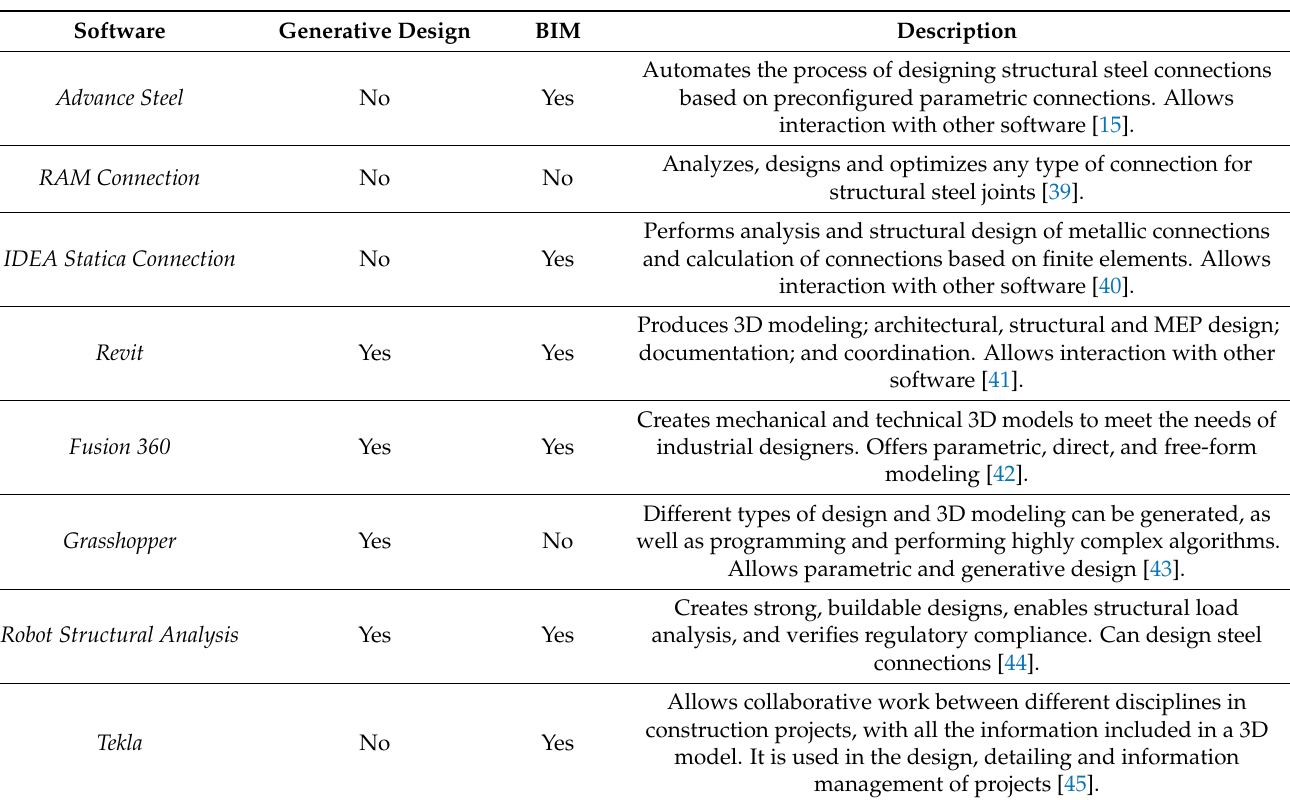
Table 1. Useful software for steel connection design. Source: the